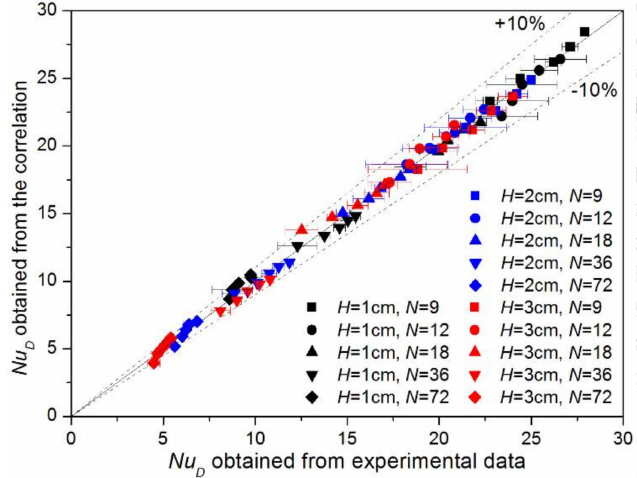
Figure 7. Comparison of Nusselt numbers from experimental data and the correlation.